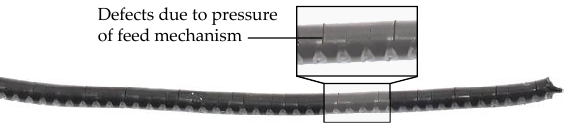
Figure 10. Representation of defects due to the pressure of the feed mechanism on the example of 3dk.